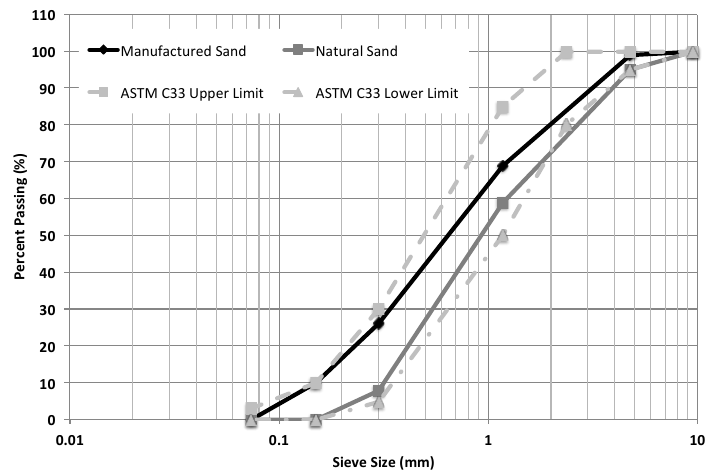
Figure 1. Gradation curves and ASTM C33 grading requirements for fine aggregates.